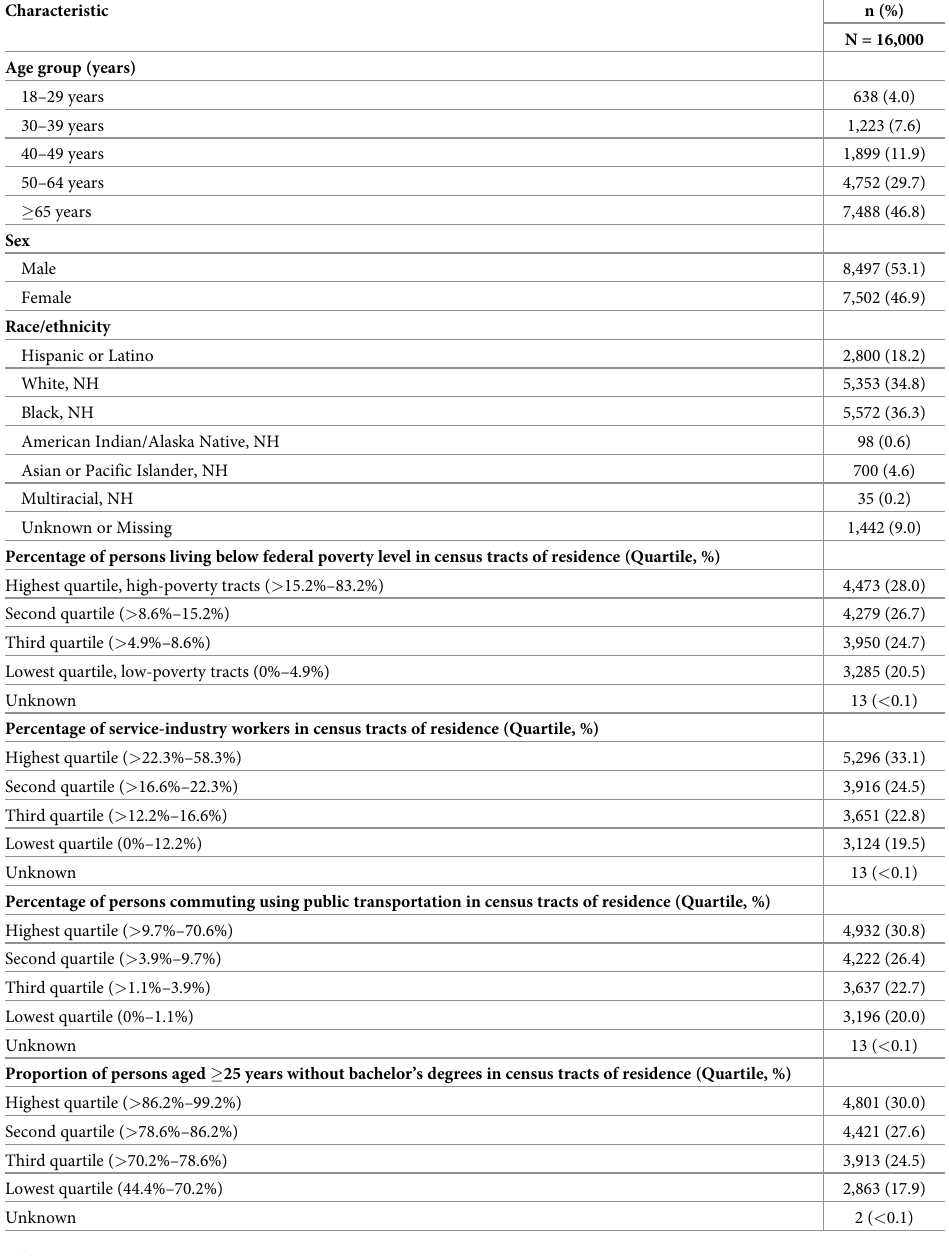
Table 1. Characteristics of adult patients ( � 18 years old) hospitalized with COVID-19 and available geocoding information—COVID-NET catchment areas in 14 states, March 1–April 30, 2020. Characteristic n